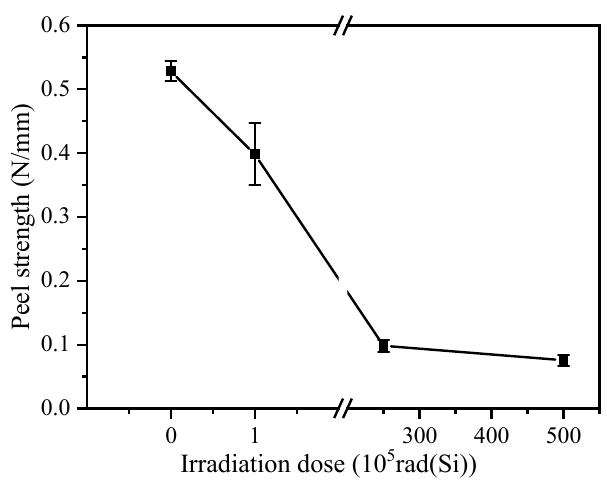
Figure 8. The change in peel strength with irradiation dose.